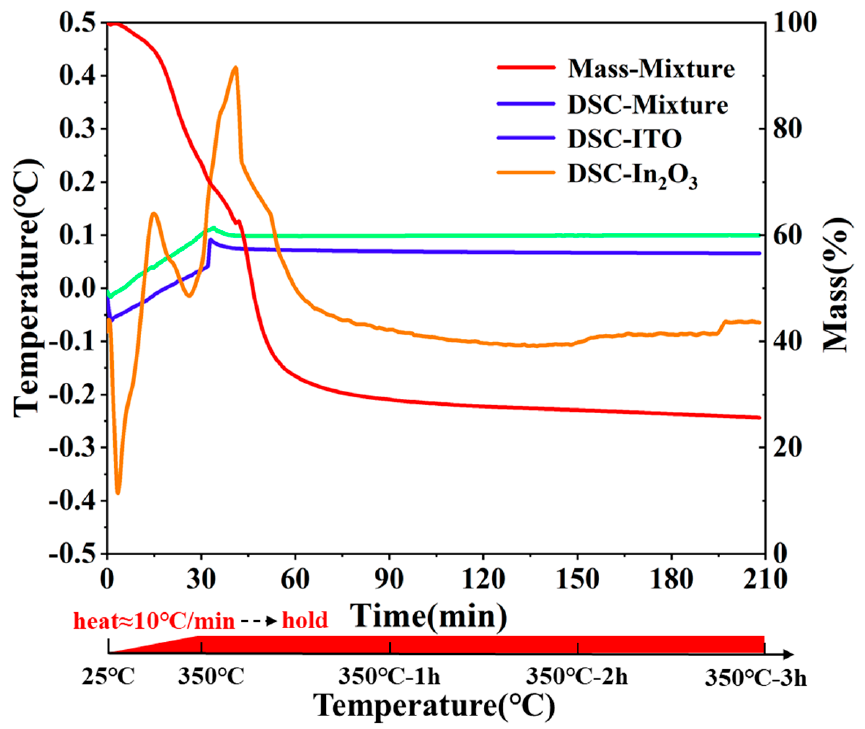
Figure 2. The DSC and TGA results of In 2 O 3 powder, ITO powder and mixture (epoxy resin, polyether amine and terpinol).